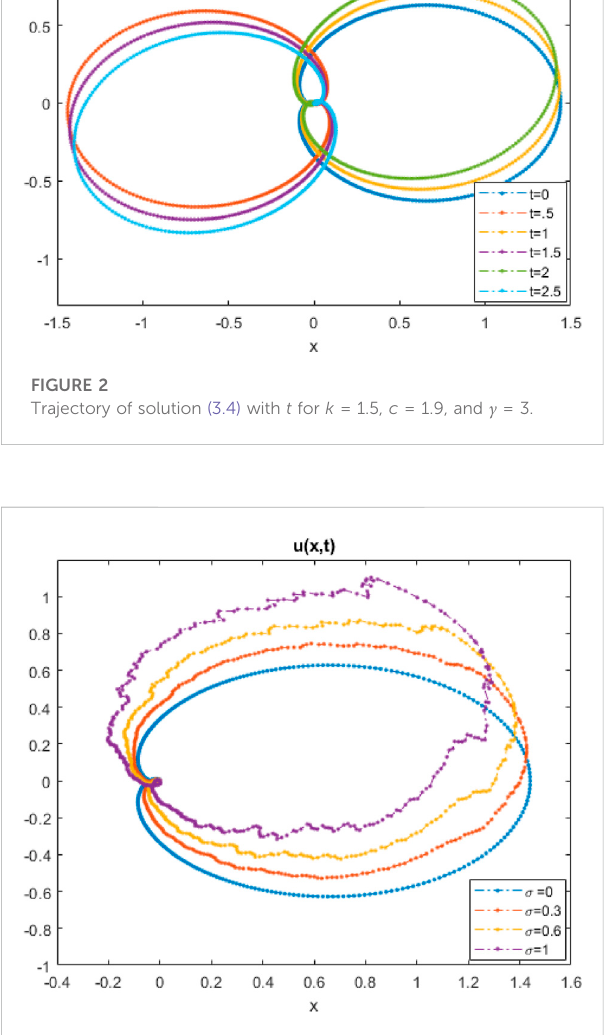
FIGURE 3 Trajectory of solution (3.4) with σ for k = 1.5, c = 1.9, and γ = 3.